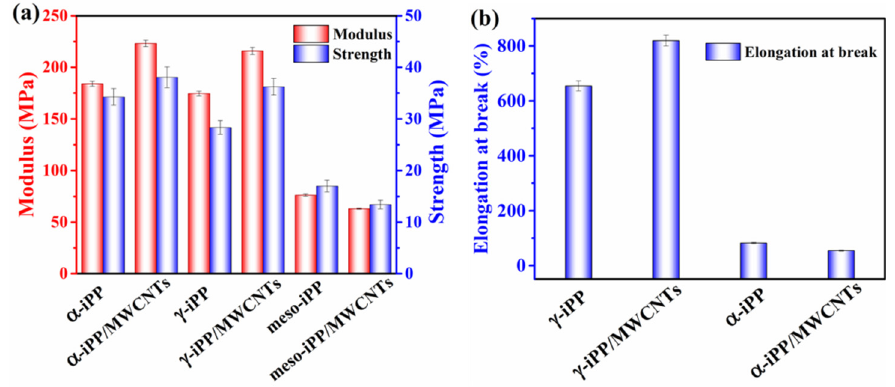
Figure 11. Mechanical properties about ( a ) modulus, yield strength and ( b ) elongation at break for neat iPP and iPP / MWCNTs